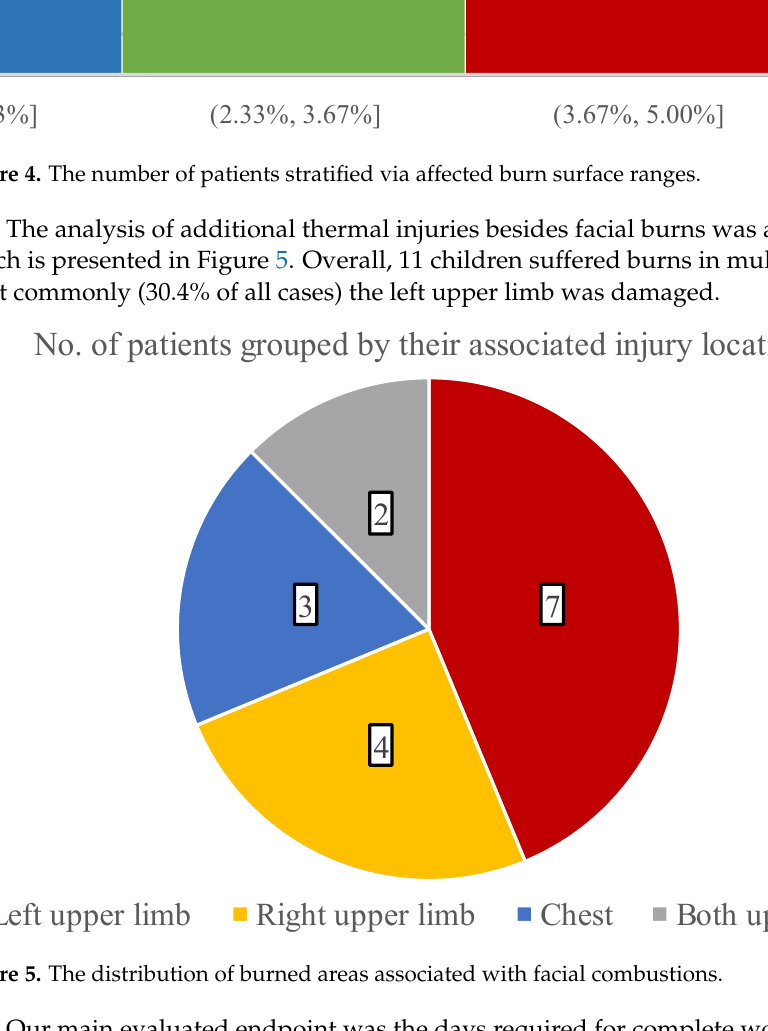
Figure 5. The distribution of burned areas associated with facial combustions.